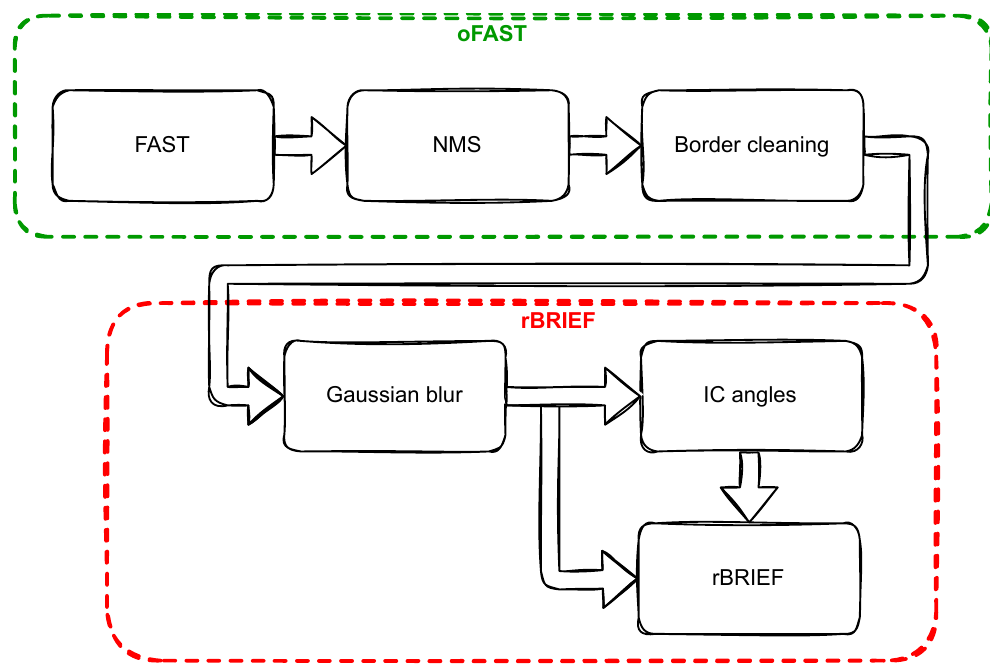
Figure 2. Overall scheme of our hardware implementation of the ORB algorithm on a SoC FPGA